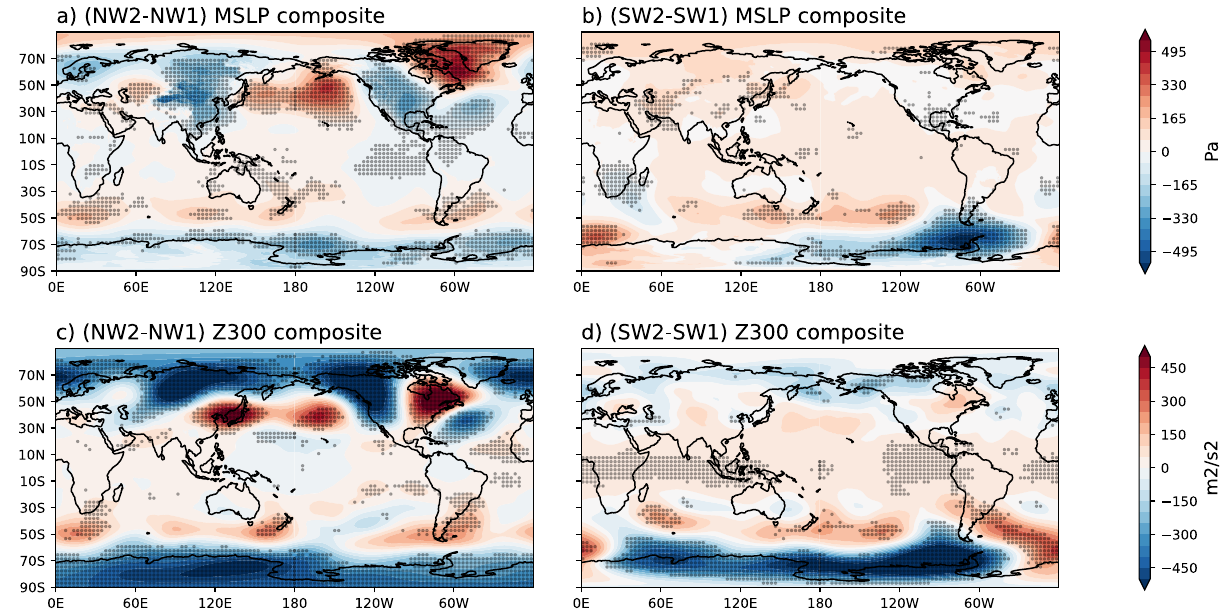
Fig. 5 MSLP and Z300 composites. Composite ( a , b ) MSLP (Pa) and ( c , d ) Z300 (m 2 s − 2 ) difference between clusters in ( a , c ) boreal winter, NW 2 – NW 1 , and ( b , d ) austral winter, S W 2 – SW 1 . Stippling shows differences signi fi cant at 95% level.